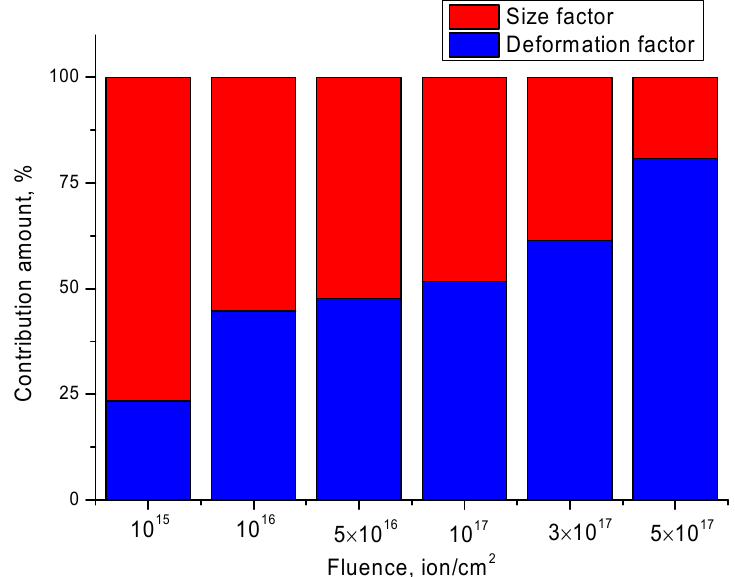
Figure 4. Results of estimation of the size and deformation factor in the broadening of diffraction peaks based on the Williamson–Hall method.